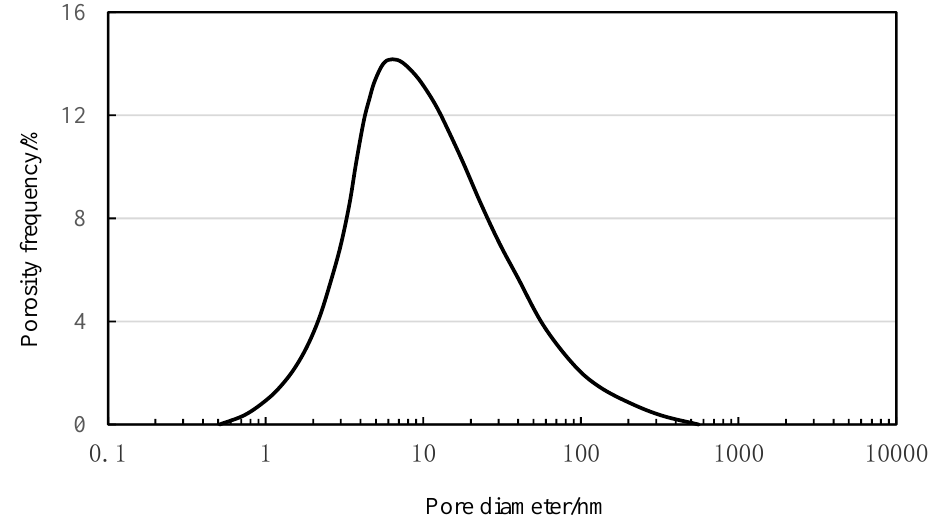
Figure 5. Pore size distribution of a Longmaxi Formation sample [33].